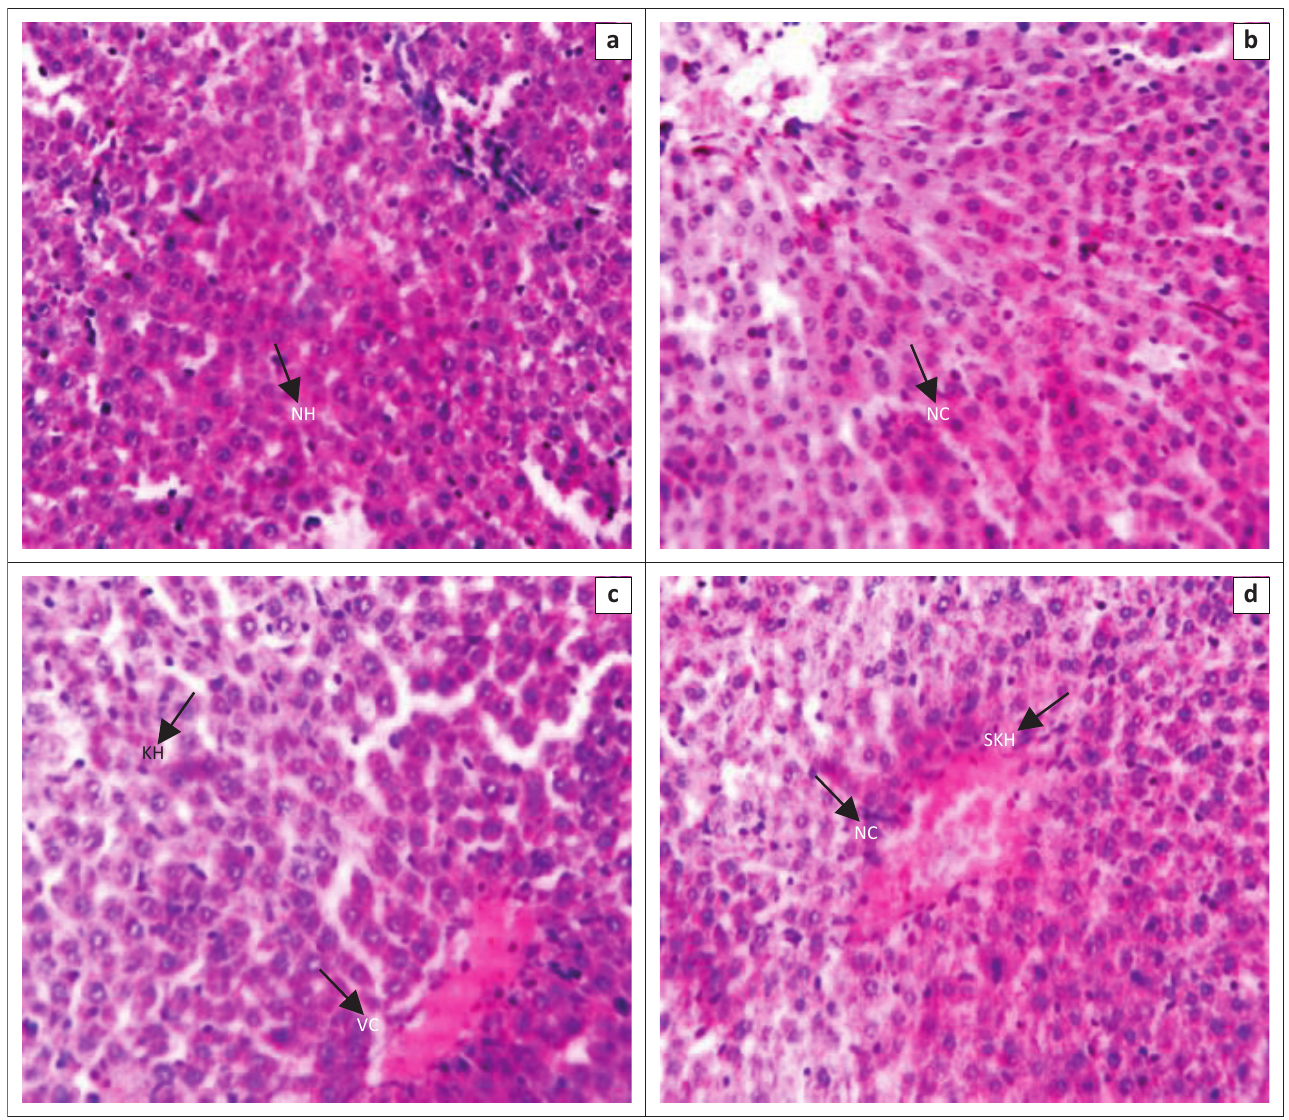
FIGURE 2: Photomicrograph showing the liver section of (a) control group (1 mL/kg distilled water) shows the normal hepatocytes; (b) rat treated with 500 mg/kg of n -hexane had slight hepatic necrosis with moderate lymphocyte hyperplasia; (c) treated with 1000 mg/kg of n -hexane extract had vascular congestion with Kupfer cell hyperplasia; (d) treated with 1500 mg/kg of n -hexane extract shows slight hepatocellular necrosis with Kupfer cell hyperplasia (haematoxylin and eosin stain; original magnification ×